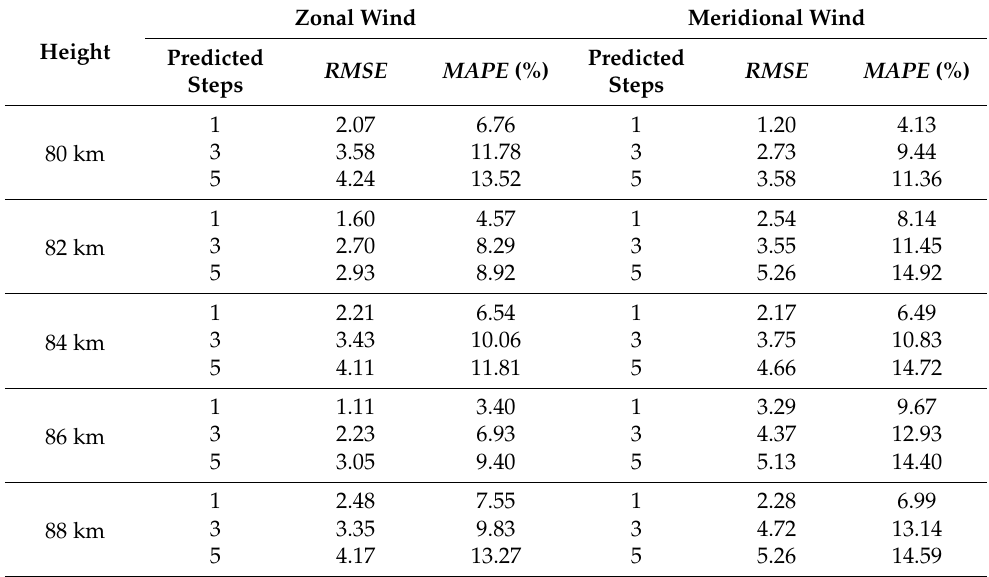
Predicted Steps